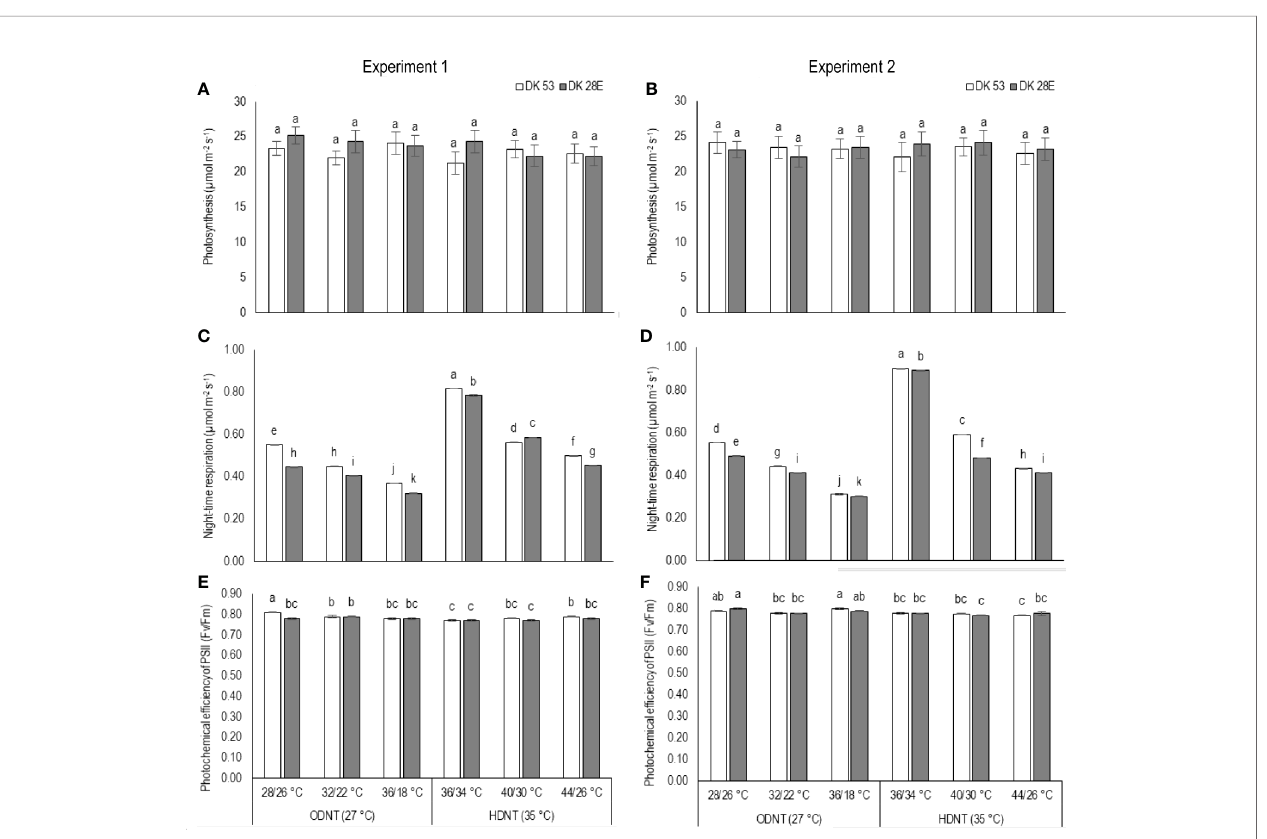
FIGURE 3 | Effect of two mean temperatures (27 and 35°C) [27°C (optimum mean daytime and nighttime temperature; ODNT) and 35°C (high mean daytime and nighttime temperature; HDNT)] with three diurnal temperature amplitudes (2, 10, and 18°C) on (A, B) photosynthesis ( P N ), (C, D) photochemical ef fi ciency of PSII ( F v/ F m) and (E, F) night respiration of two sorghum hybrids [DK 53 (white bar) and DK 28E (gray bar)]. Different letters in bar indicates signi fi cant difference according to Tukey ’ s HSD ( P <0.01; the test was conducted independently for each experiments). Each bar is mean value with standard error. Dry weight (DW).